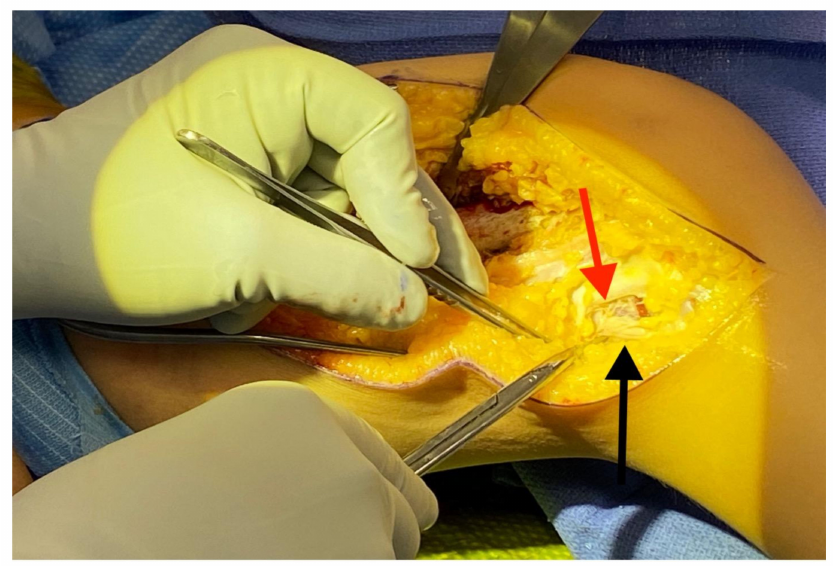
Figure 3. Isolation of the common peroneal nerve (red arrow) under the biceps femoris (black